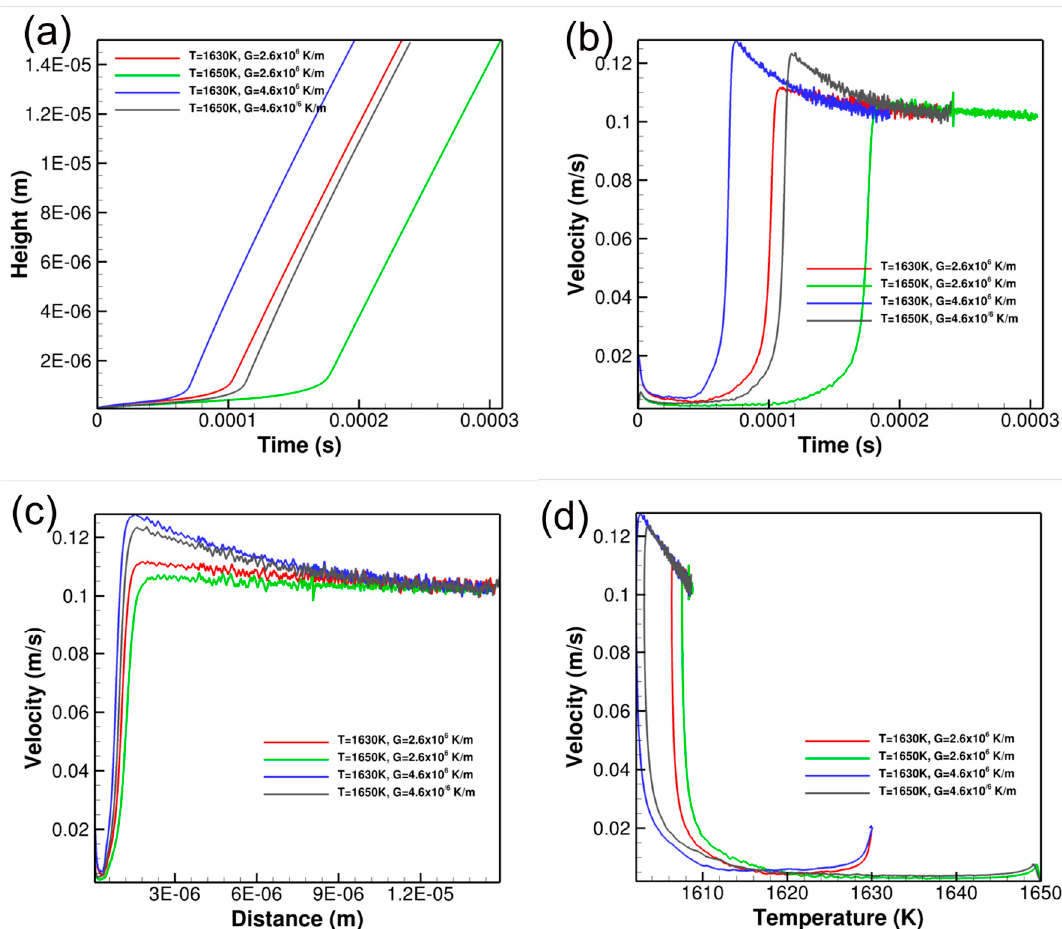
Figure 11. 2D simulations of solidification using random nucleation and a temperature gradient of 2.6 × 10 6 K/m. Simulation volume 5 µ m × 15 µ m. Simulated s-l interface ( a ) position as function of time and velocity as function of time ( b ) distance ( c ) and as a function of interface temperature ( d ).